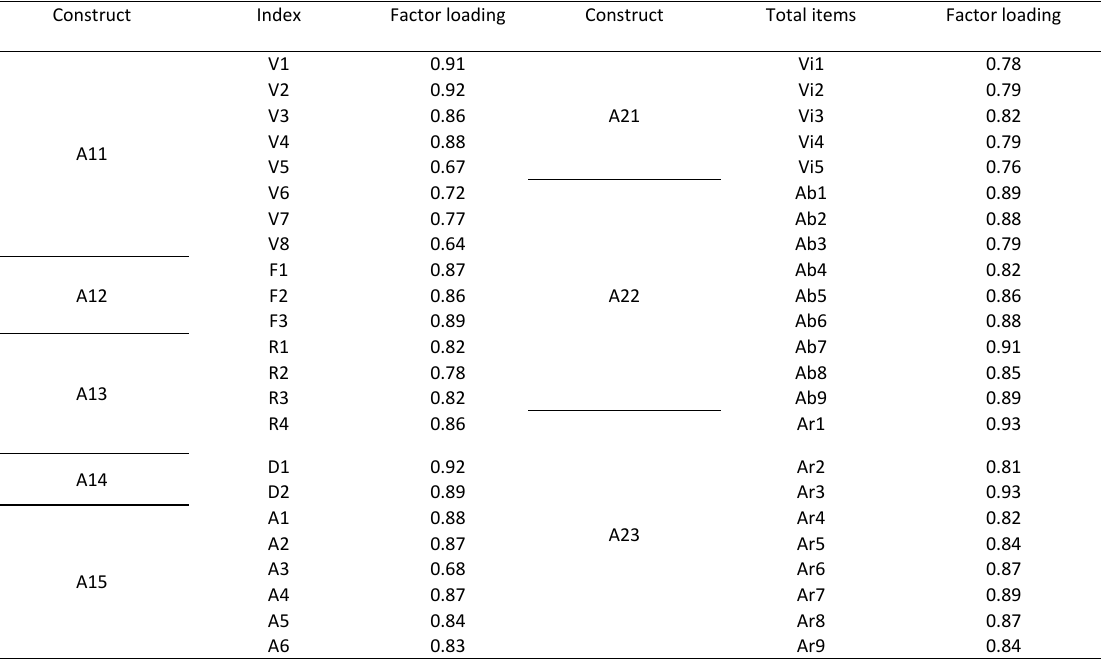
Table 5: Factor loading coefficients